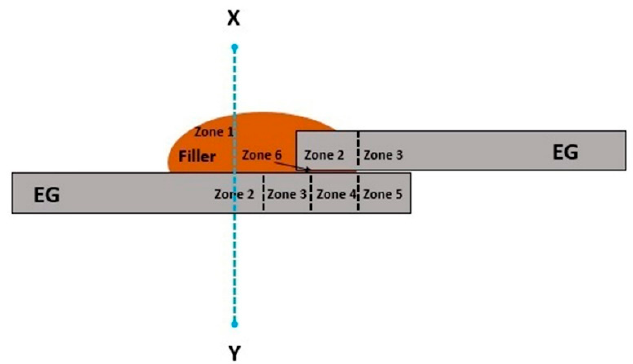
Figure 2. Microhardness measurement across the lap joint in various heat-affected zones (HAZs). XY shows the line profile for the hardness measurement.